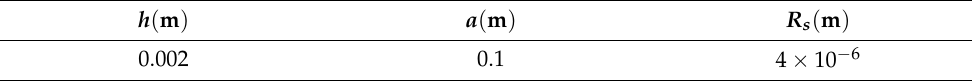
Figure 6. The displacement field corresponding to vibration mode B (cid:2876) . 3.2. Influences of Soft Shell Parameters on Band Gap As known from the above section, the additional soft shell plays an active role in widening the band gap but does not affect the starting frequency. Here, the elasticity mod ‐ ulus, Poisson’s ratio, and density of soft shell were picked to investigate the influences of the materials’ parameters on the band gap. All the parameters except for the materials’ parameters of the soft shell are shown in Tables 1 and 2, and the materials’ parameters of the soft shell were presupposed to be elasticity modulus 𝐸 (cid:3028) (cid:3404) 1.175 (cid:3400) 10 (cid:2873) N/m (cid:2870) , Pois ‐ son’s ratio 𝜇 (cid:3028) (cid:3404) 0.469 , and density 𝜌 (cid:3028) (cid:3404) 0 kg/m (cid:2871) , respectively. What should be noted is that all the others are the default if one was chosen as the influencing parameter. Figure 7 shows the band structures of LRPC DPSs if the densities of soft shell are 𝜌 (cid:3028) (cid:3404) 10 kg/m (cid:2871) , 𝜌 (cid:3028) (cid:3404) 20 kg/m (cid:2871) and 𝜌 (cid:3028) (cid:3404) 30 kg/m (cid:2871) , respectively. By comparing Figure 7 with Figure 2a, the density of soft shell has little effect on bands corresponding to B (cid:2869) – B (cid:2877) , but has obvious influences on some flat bands, which makes the corresponding frequen ‐ cies of flat bands reduce and leads the flat bands to decline to the frequency region under the band corresponding to B (cid:2876) . It can be understood that the increase of soft shell density makes the equivalent mass of flat band modes increase, which leads the corresponding frequencies to reduce. In fact, the effects of flat bands on band gap can be ignored if only a few flat bands are located in the frequency range of the original band gap. Figure 8 displays the band structure of LRPC DPS if the Poisson’s ratio of soft shell is 𝜇 (cid:3028) (cid:3404) 0.2 . By comparing Figure 8 with Figure 2a, the band structures are the same; that is, Poisson’s ratio of the soft shell has no effect on the band structure. Because Poisson’s ratio determines shear modulus if elasticity modulus is given, it illustrates that adding a soft shell only affects the bands corresponding to flexural vibration mode, but not longi ‐ tudinal vibration mode.